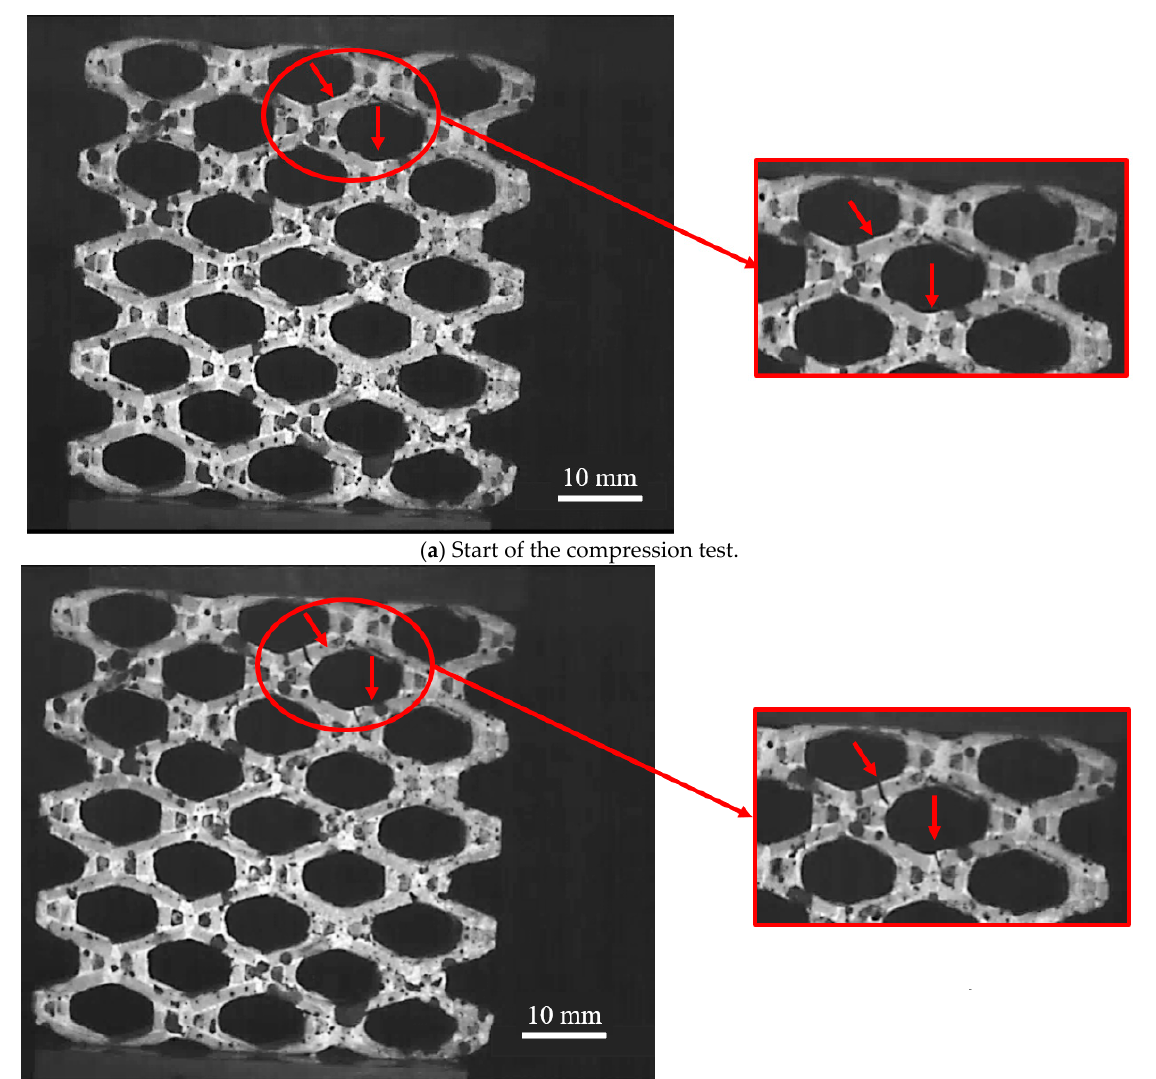
Figure 3. Different stages of the compression test: ( a ) compression test start and ( b ) at fracture of the lattice in the building blocks and the PZT-filled silicone resin. In the figure, one sample is shown as an example.